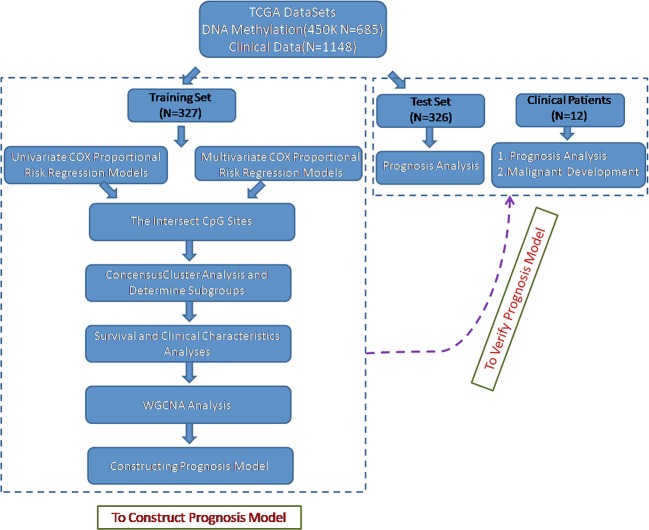
Flowchart describing the schematic overview of the study design.